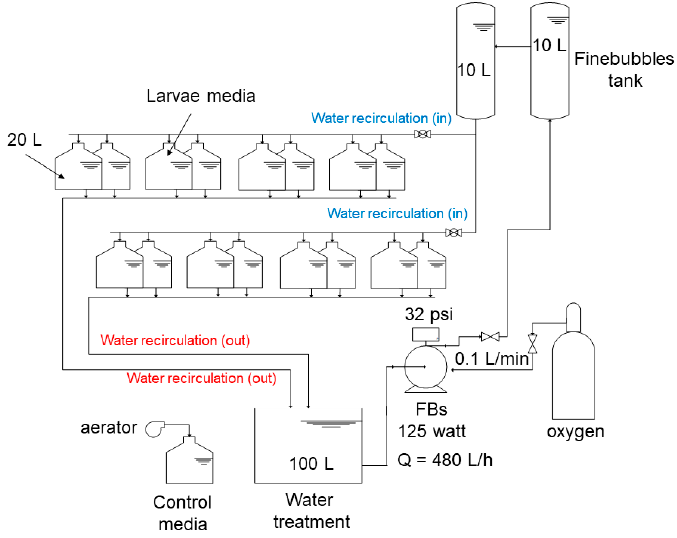
Figure 1. Schematic diagram of recirculating aquaculture system (UFBs-RAS) for striped catfish ( Pangasianodon hypophthalmus ) larviculture.